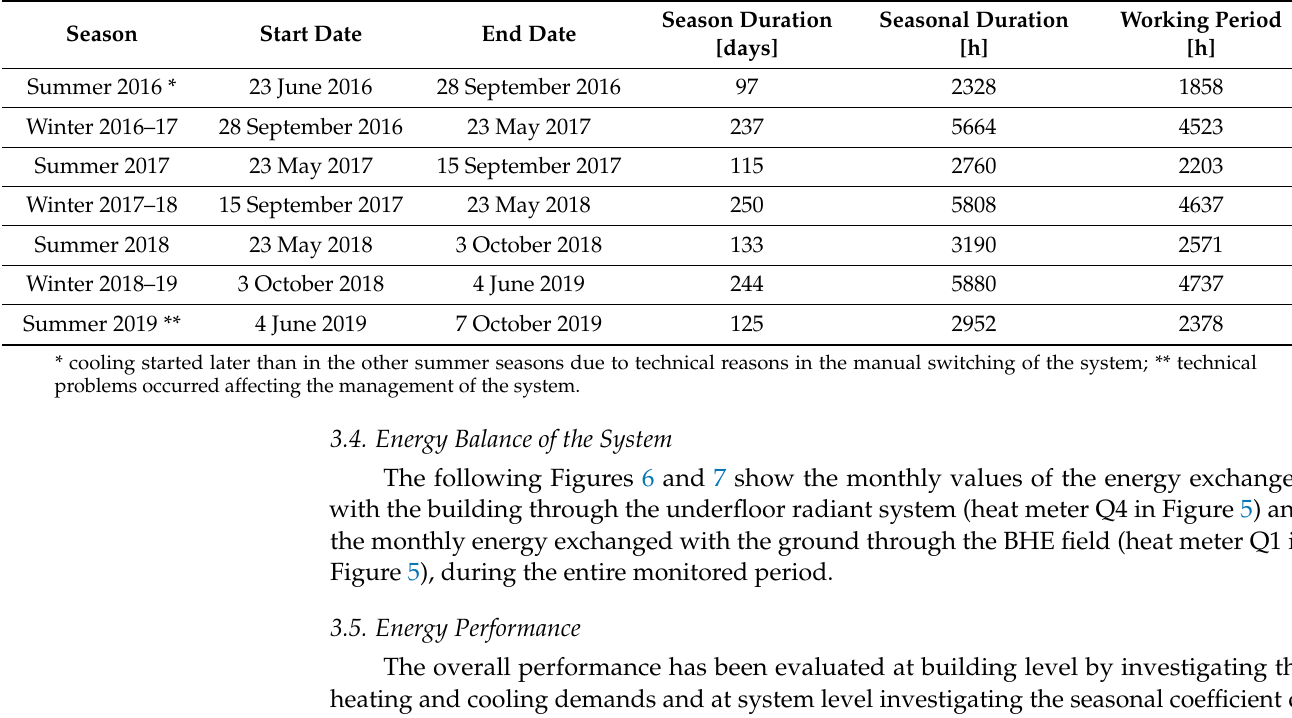
Figure 7. Monthly energy exchanged with the ground (at the heat meter “Q1”) during the monitoring (years and months in the abscissa labels; source: [22]). 3.4. Energy Performance The overall performance has been evaluated at building level by investigating the heating and cooling demands and at system level investigating the seasonal coefficient of performance of the GSHP, the recharge of the ground and the efficiency of geocooling. Based on monitored data and geometric features of the building, such as the reference energy surface, i.e., the surface of the thermal zones to be heated and cooled, the following